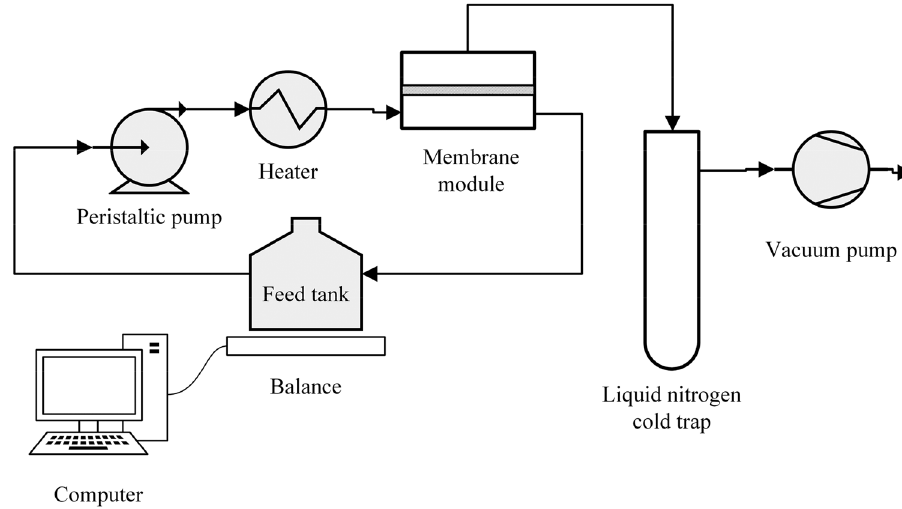
Fig. 1 Schematic diagram of pervaporation experiment